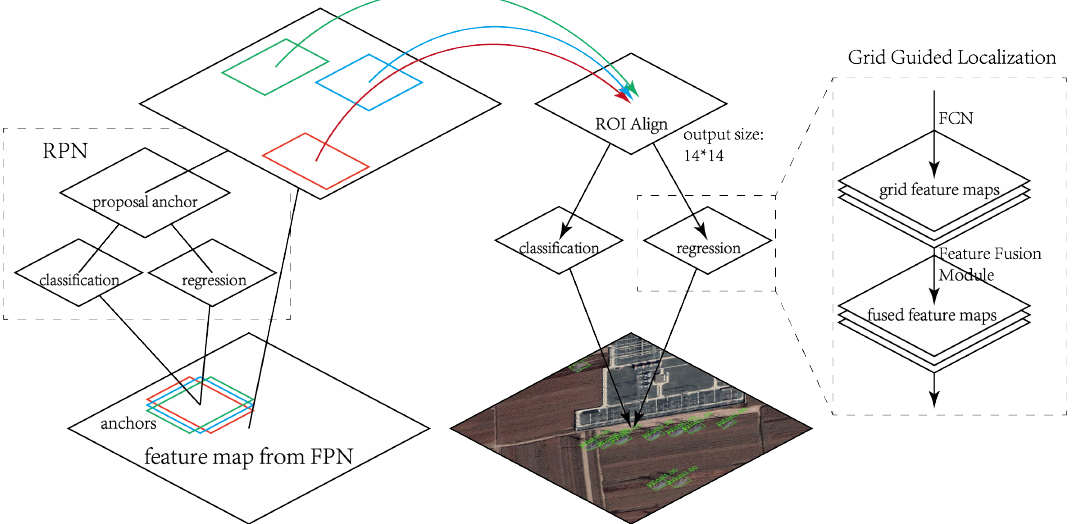
Figure 7. Structure of Grid R-CNN [22]. The input of Grid R-CNN is the output of FPN [43]. Tetragons with different colors represent different anchors. RPN (Region Proposal Network) is a fully convolutional network, classifying the anchors to foreground/background and regressing the bounding-box sketchily. ROI is the abbreviation of region of interesting and ROI Align layer [21] is used to reconcile the size of feature maps. Grid Guided Localization [22] adopts a fully convolutional network to obtain grid feature maps and fuses